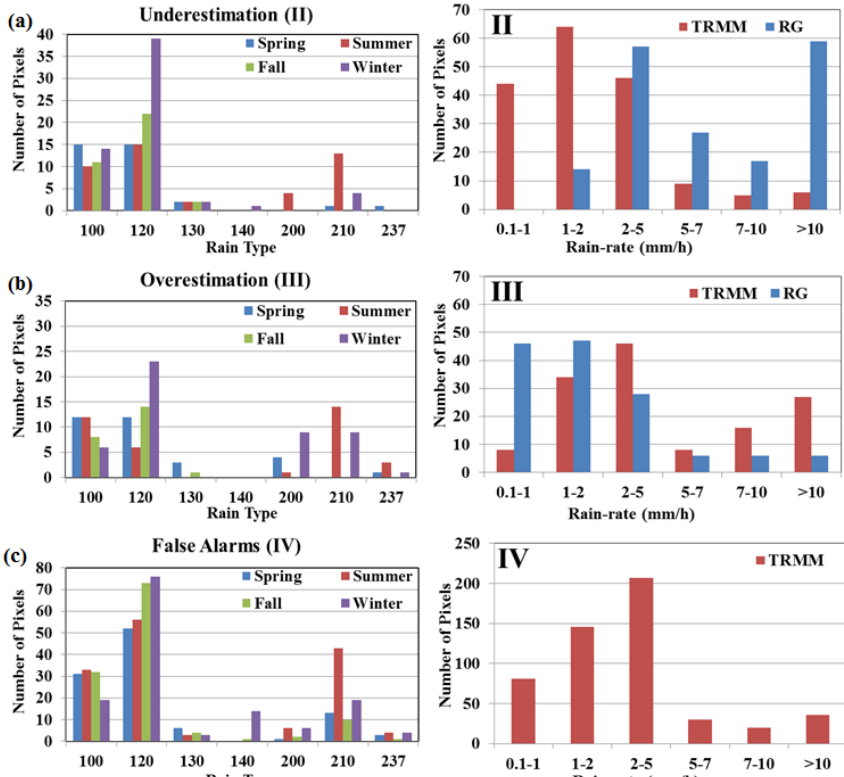
Figure 6. Histogram of rain type (left panels) and observed RG rain rate and NSR from TRMM (right panels) distributions for the different errors: (a) II (UND); (b) III (OVR); and (c) IV (FA). The error classification is provided in Table 4. The rain type categories correspond to the TRMM 2A23 rain-type flag: 100 – stratiform certain, 120 – probably stratiform, 130 – maybe stratiform, 140 – maybe stratiform or maybe transition or something else, 200 and 210 – convective certain, 237 – probably convective. (For further details please see the 2A23 documentation at